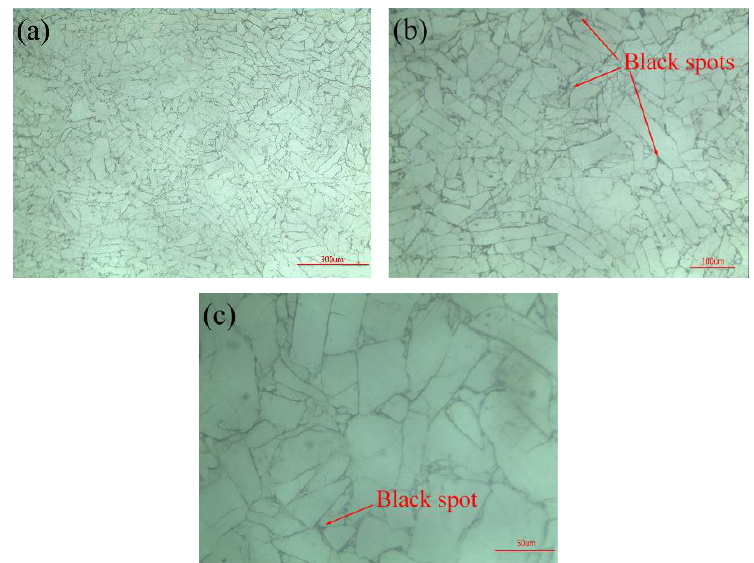
Figure 6. Optical micrographs of the cross-section of a sample: ( a ) 100 × magnification, ( b ) 200 × magnification, ( c ) 500 × magnification.